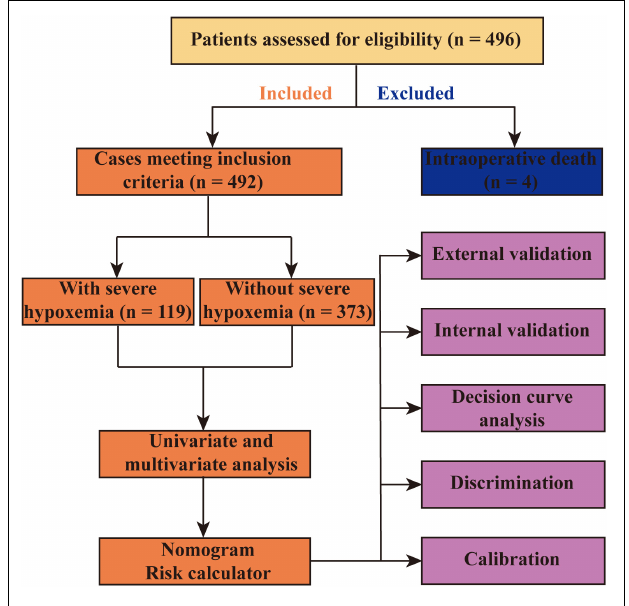
FIGURE 1 | Flow chart of the